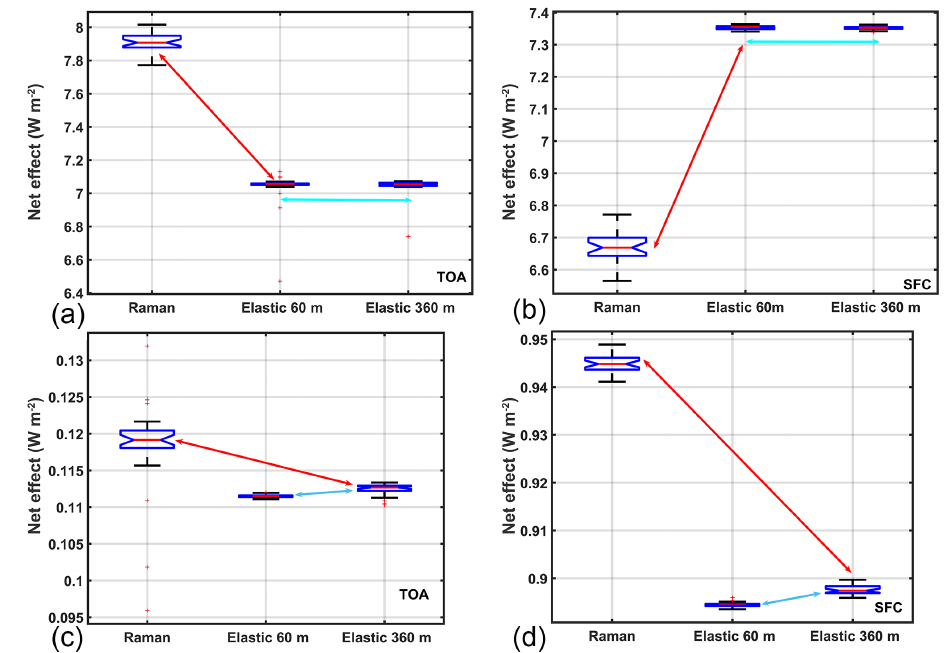
Figure 3. The direct radiative effect for the dust aerosol case study (a, b) on 3 July 2014 and biomass burning case on 19 June 2013 (c, d) computed for retrievals obtained with Raman lidar channel smoothed over a window of 360m, elastic channel at full resolution (60m) and elastic channel smoothed over a 360m window to be compared with the Raman channel . The results, represented as a distribution of values obtained with the Monte Carlo simulations by the box plots, are calculated at TOA (a, c) and SFC (b, d) . As is clearly visi- ble, the larger discrepancy in radiative effects is related mostly to the lidar measurements technique (red arrows), not the data processing constraints/assumptions (blue